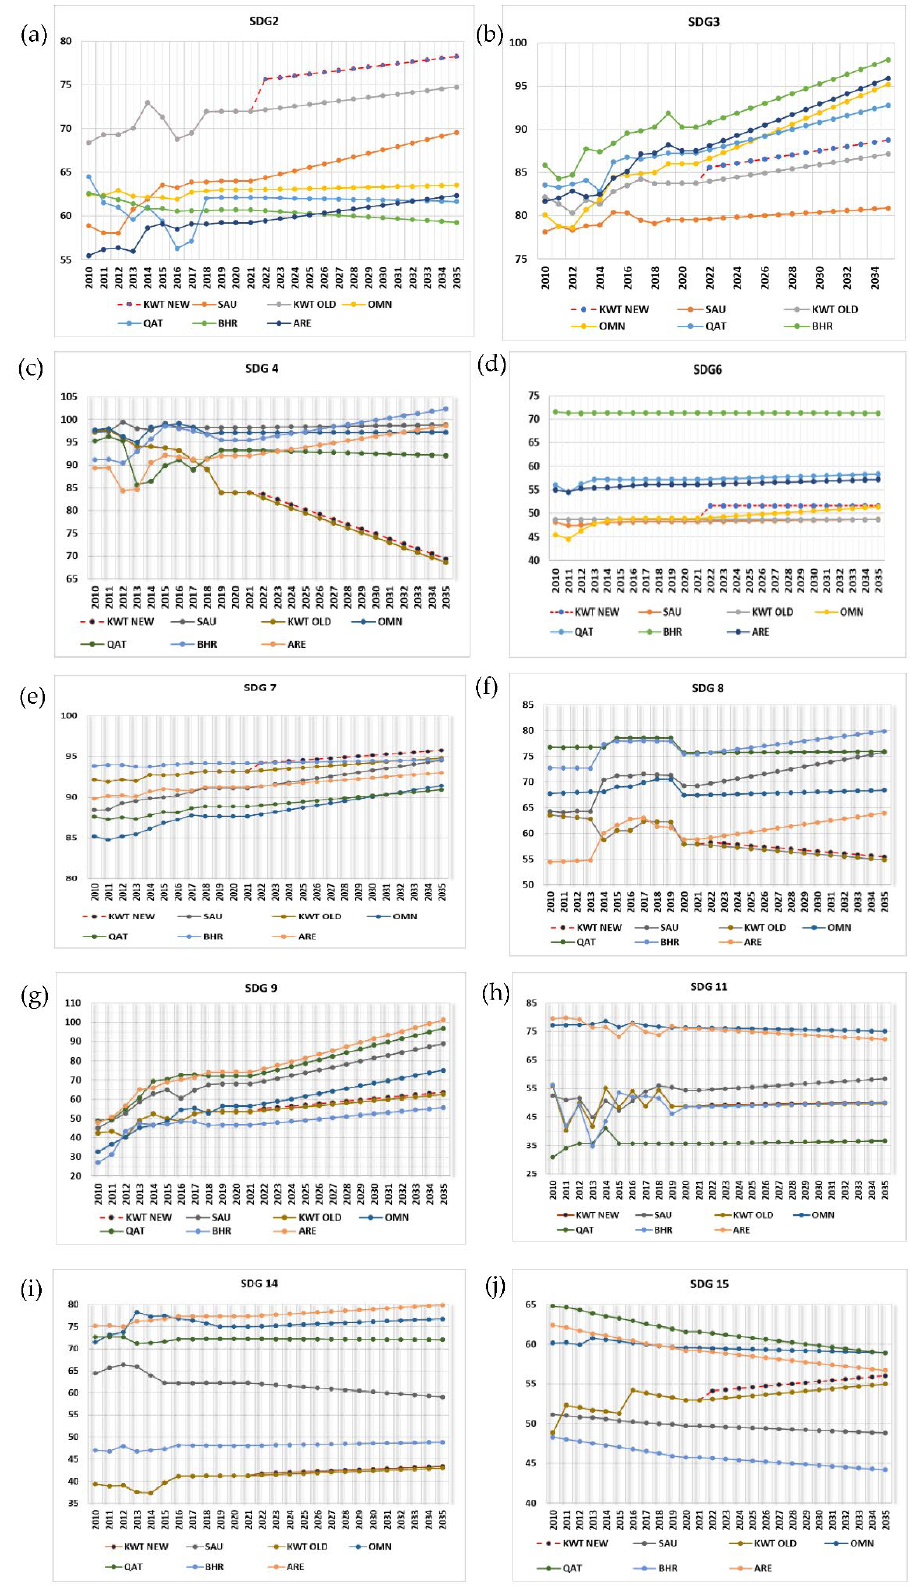
Figure 7. GCC SDGs ( a – j ) forecast until the year 2035.